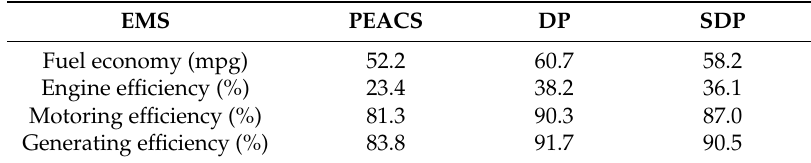
Table 4. Simulation results for CYC_1015.